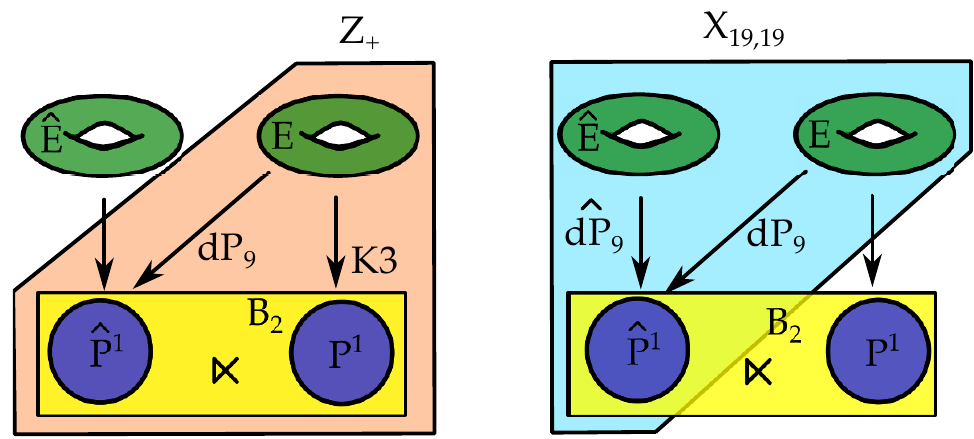
Figure 4 . A sketch of the geometry X F;n . The two elliptic curves b E and E are shown as well as the non-trivial way they are (cid:12)bered over the base B 2 = b P 1 n P 1 . The (cid:12)bration result in the dP 9 s, as well as the K3, as indicated by the boxes. For the general construction in section 6, the base B 2 is required to only have a projection to b P 1 and its (cid:12)ber P 1 is allowed to have degenerations into multiple components over points in the base b P 1